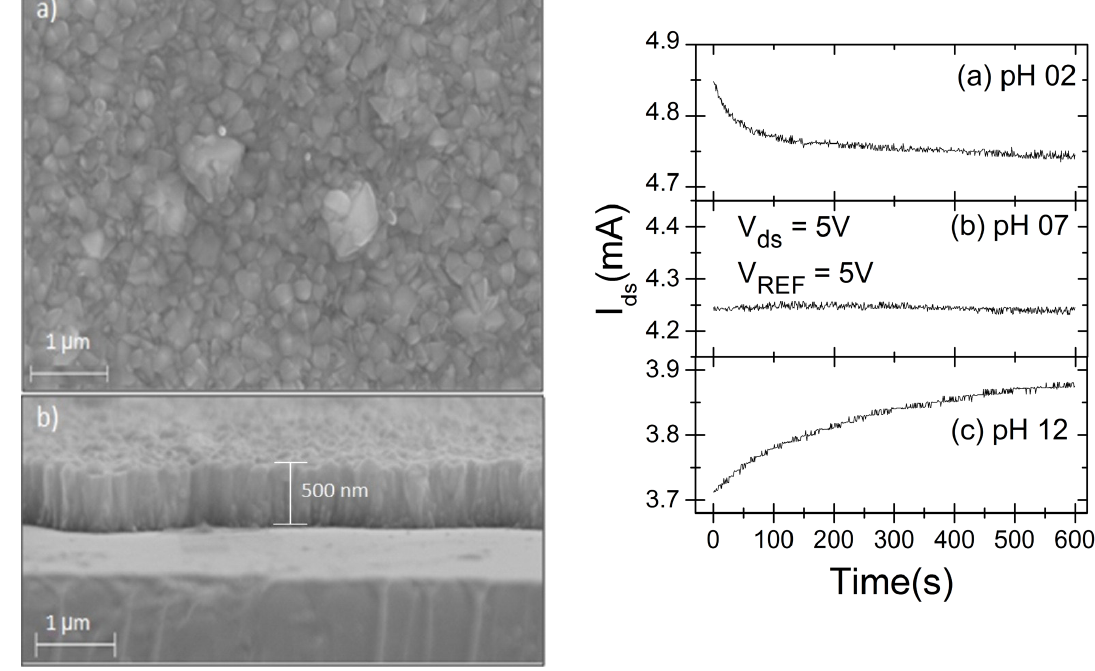
Fig. 3. Time evolution of the EGFET electric current for varied solution pH values: (a) pH 02, (b) pH 07, and (c) pH